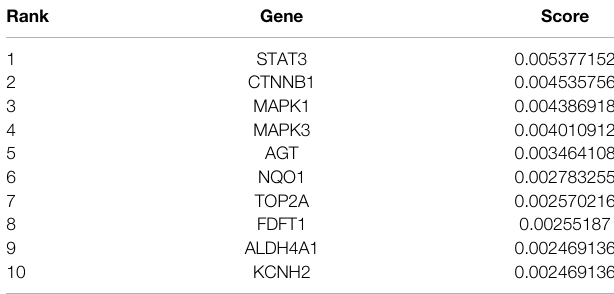
TABLE 1 | Top 10 genes ranked by random walk with start algorithm. Rank Gene